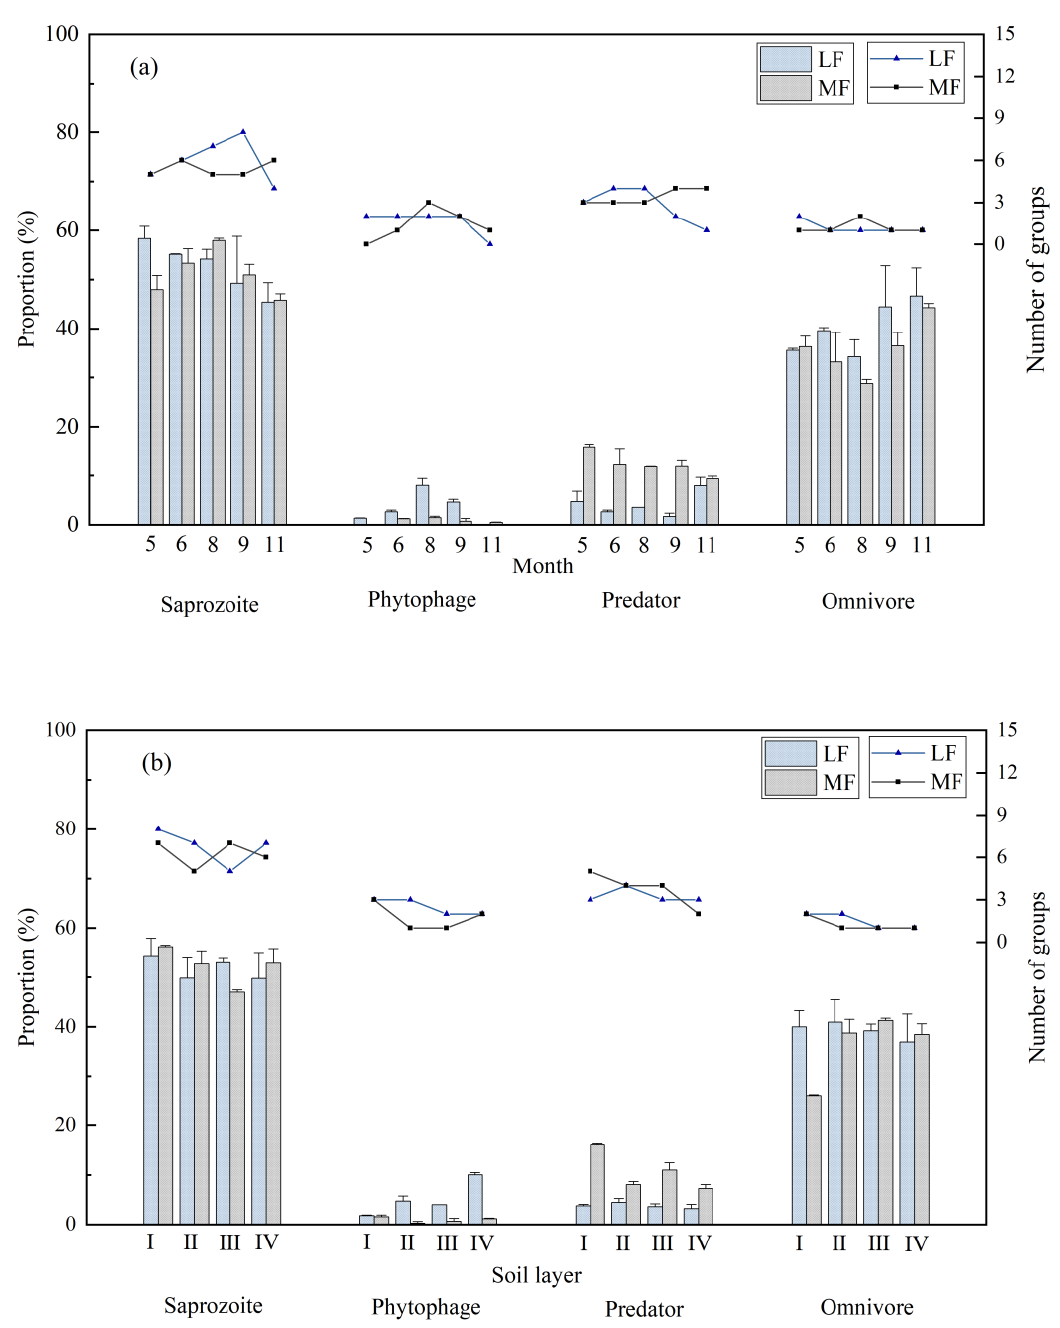
Figure 3. Temporal and vertical distribution of functional groups in the two forest types. ( a ) Temporal distribution; ( b ) vertical distribution.